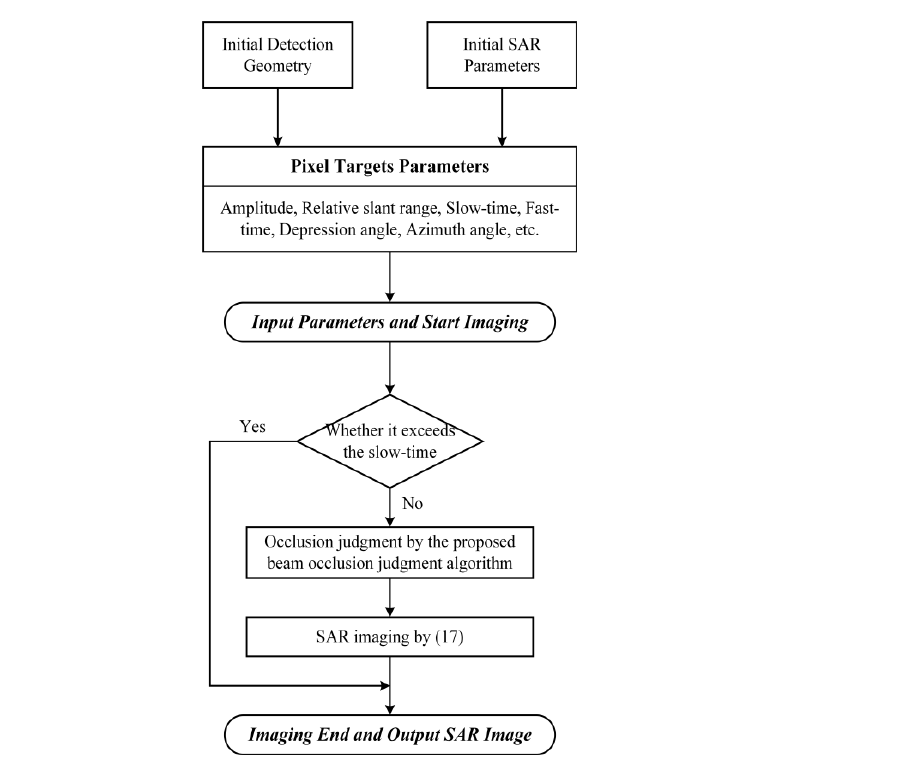
14 of 21 Figure 9. Occlusion judgment results of the proposed beam occlusion judgment. Theoretically, according to the spatial geometric relationship between the SAR platform and the cylinder as shown in Figure 8, the feature of light propagation in a straight line and the spherical wave characteristics of the SAR beam, it can be calculated that the direction of the shadow caused by cylinder occlusion at slow time 0 η = should diverge outward. As can be seen from Figure 9, the shadow direction of the cylinder is offset within the range of SAR beam irradiation, which is consistent with the above analysis. Moreover, the direction of pur-